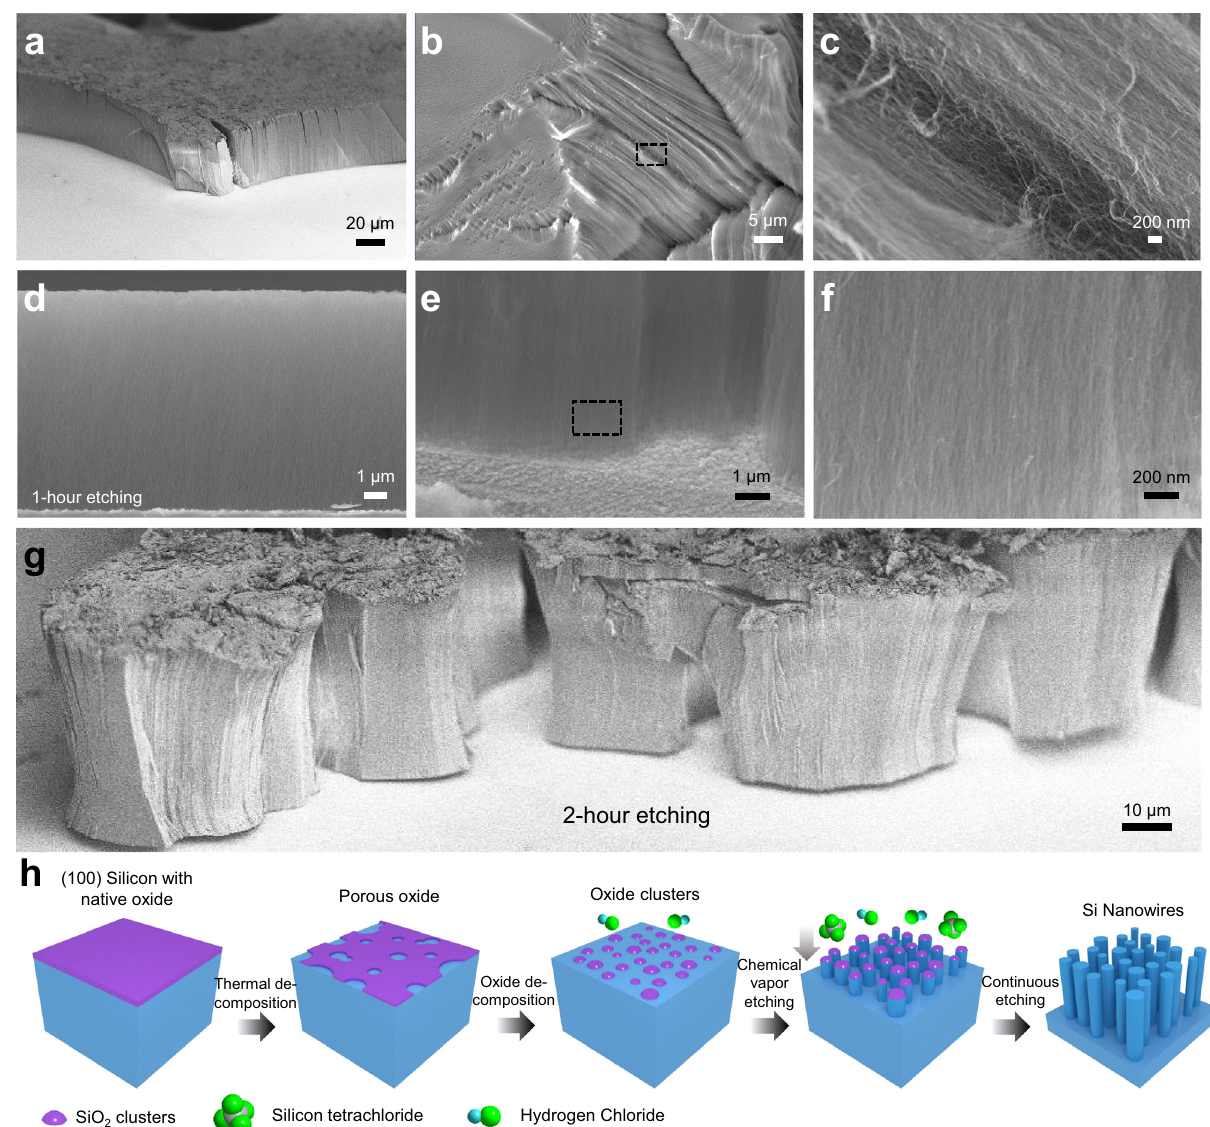
Fig. 1 Morphology of the vertically aligned high-density SiNWs formed on the (100) silicon substrate. a Tilted, b low, and c high magni fi cation planar views of the vertically aligned SiNWs. d SEM image of the vertically aligned SiNWs on the (100) Si wafer after 1 h etching. e High magni fi cation SEM image of the bottom interface between SiNWs and etched Si substrate. f Enlarged image of the dashed rectangular area in ( e ). g Tilted views of the vertically aligned SiNWs after 2 h etching. h Schematic illustration of the oxide-induced etching process to fabricate ultra-narrow Si